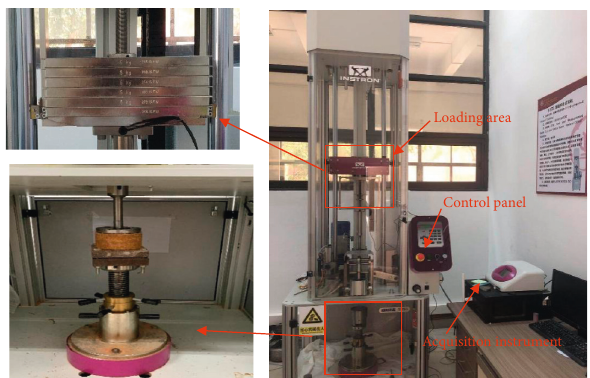
Figure 5: Drop weight tester.